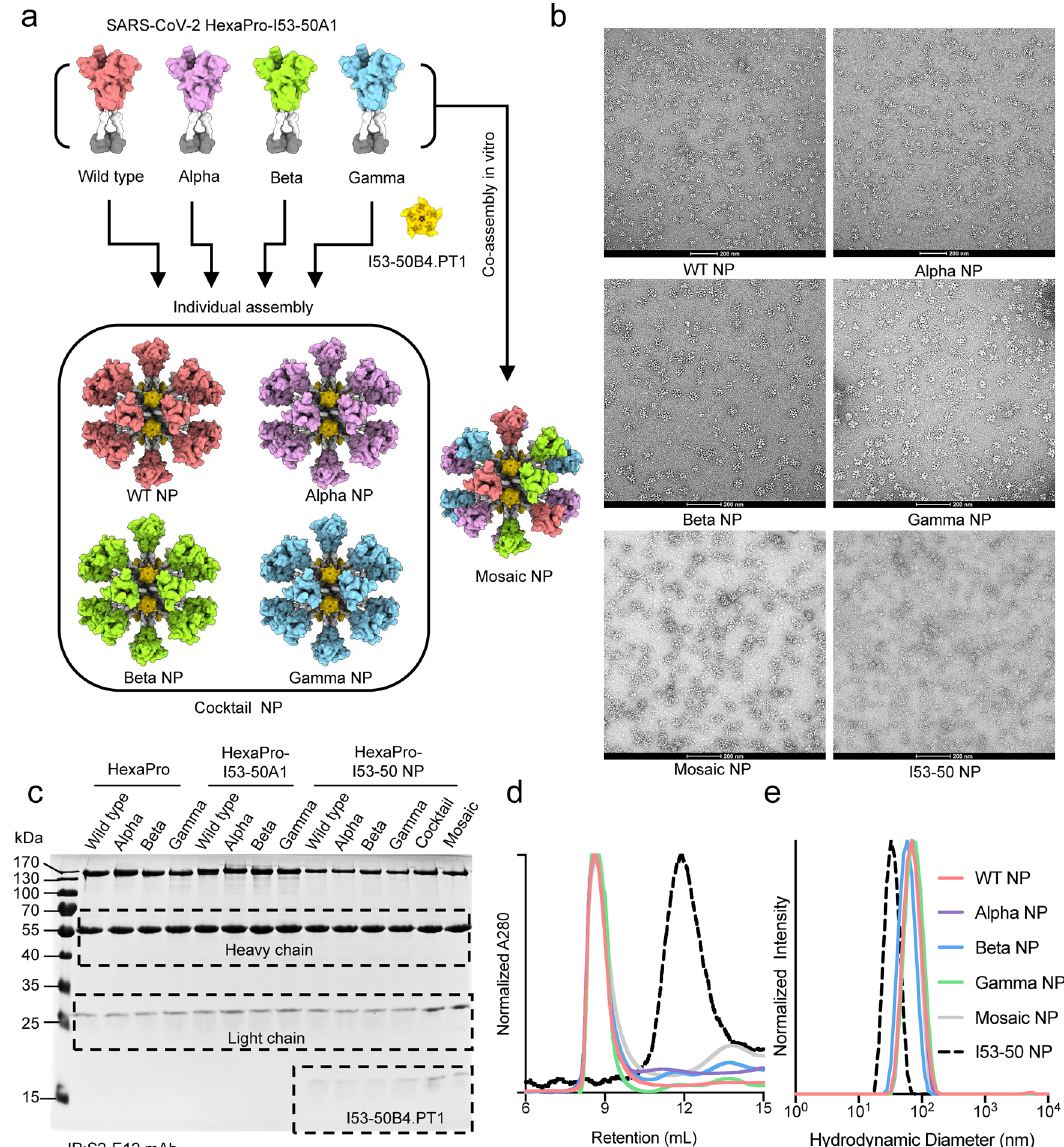
Fig. 1 Molecular design and characterization of SARS-CoV-2 HexaPro-based nanoparticle vaccines. a Schematic diagram of SARS-COV-2 HexaPro- bearing nanoparticle vaccines. Cocktail NP includes the four individual HexaPro-I53-50 NPs from SARS-CoV-2 prototype, B.1.1.7 (Alpha), P.1 (Gamma), and B.1.351 (Beta) variants. Mosaic NP includes the four HexaPro from SARS-CoV-2 prototype, B.1.1.7, P.1, and B.1.351 variants fused to I53-50A1 and assembled with I53-50B.4PT1 in vitro. The fi gure was created with PyMOL-2.5.2 and UCSF ChimeraX-1.1.1. b Negative-staining electron microscopy images of SARS-CoV-2 HexaPro-based immunogens and individual I53-50 nanoparticles. Scale bar, 200 nm. Similar assay was conducted multiple times to verify the integrity and ef fi cacy of the self-assembled HexaPro-based nanoparticle vaccine. c Immunoprecipitation analysis of puri fi ed HexaPro immunogens and SARS-CoV-2 RBD-speci fi c S2-E12 neutralizing monoclonal antibody. IP immunoprecipitation. Similar analysis has beenconducted at least three times. d Size exclusion chromatography pro fi les of SARS-CoV-2 HexaPro-based nanoparticles and individual I53-50 nanoparticles on a Superose 6 Increase 10/ 300 GL column. e Dynamic light scattering of SARS-CoV-2 HexaPro-based nanoparticles and individual I53-50 nanoparticles recorded using a Zetasizer Ultra instrument. Source data are provided as a Source Data fi